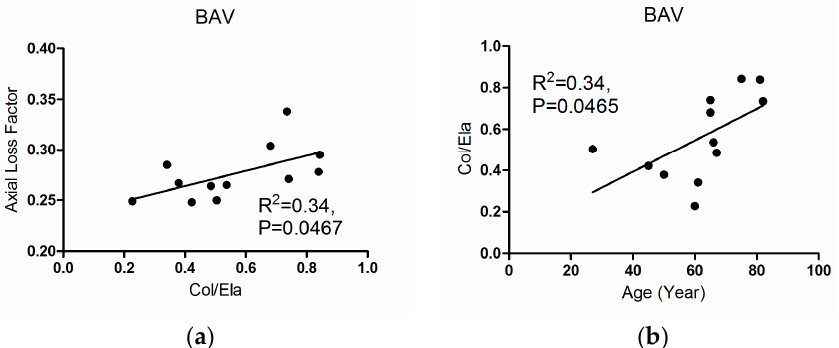
Figure 7. ( a ) Axial loss factor with respect to Col/Ela for the BAV group; ( b ) Col/Ela with respect to age for this group.